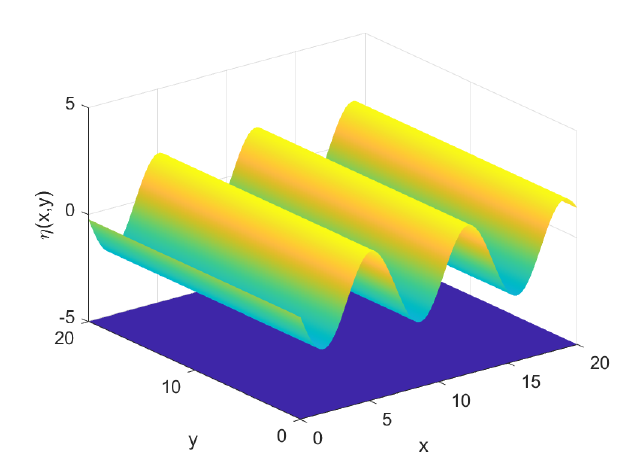
Figure 10. 2-D Numerical Simulation of an Incoming Wave in a Flat Bottom Domain without Porous-Media.